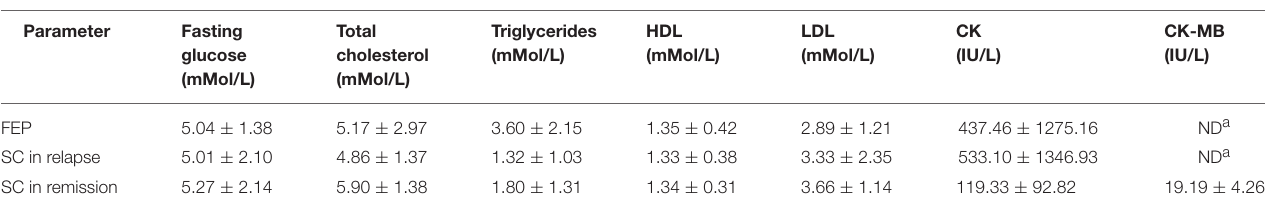
TABLE 2 | Laboratory values of cardiometabolic